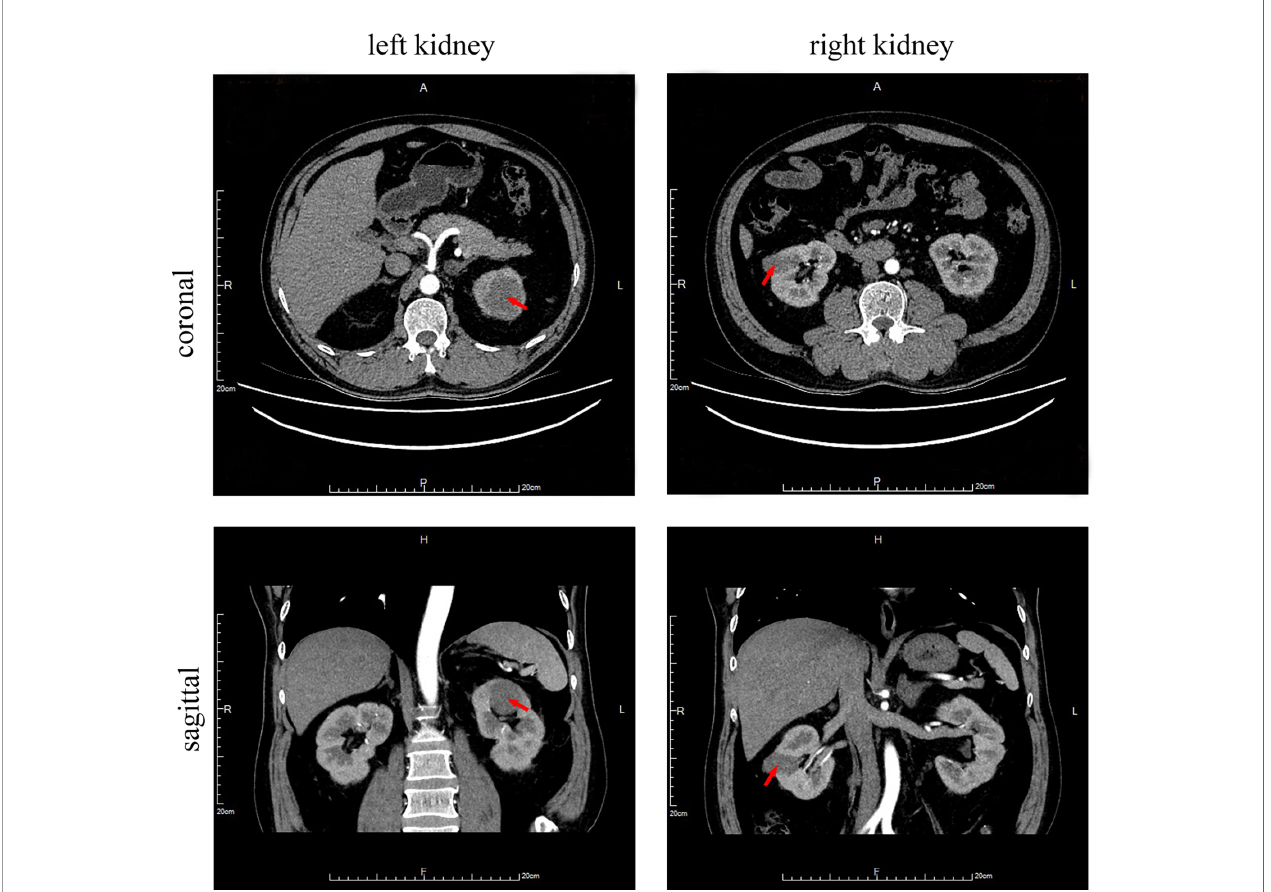
FIGURE 2 | Abdomen CT scan with contrast media. Circular iso-density lesions of about 4.4 * 4.2 cm in the upper left kidney (arrow) and an oblong iso-density foci of about 3.4 * 2.1 cm in the middle of the right kidney